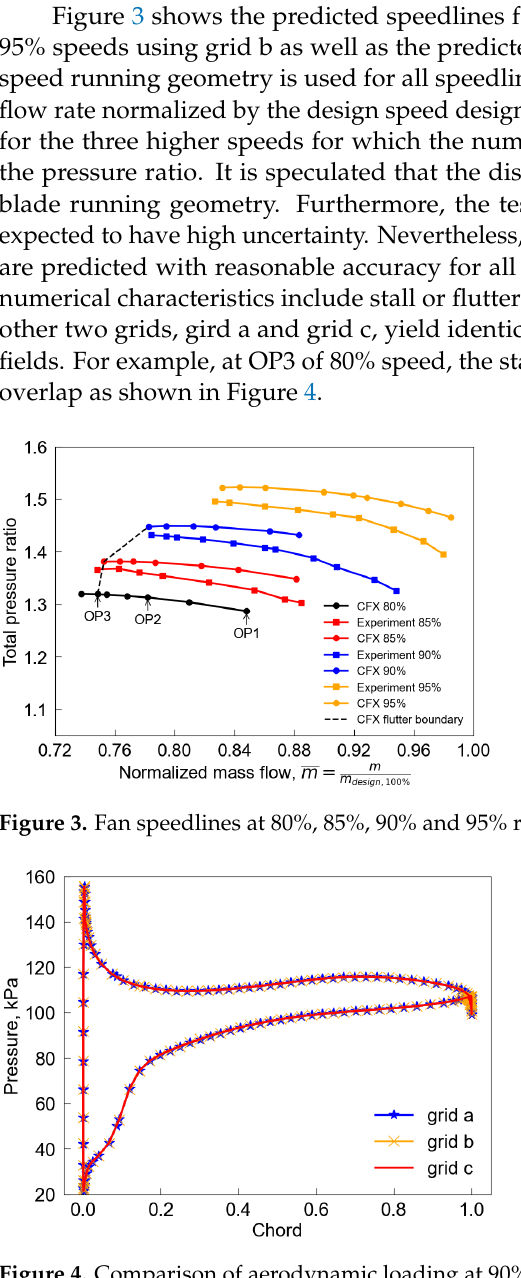
Figure 4. Comparison of aerodynamic loading at 90%